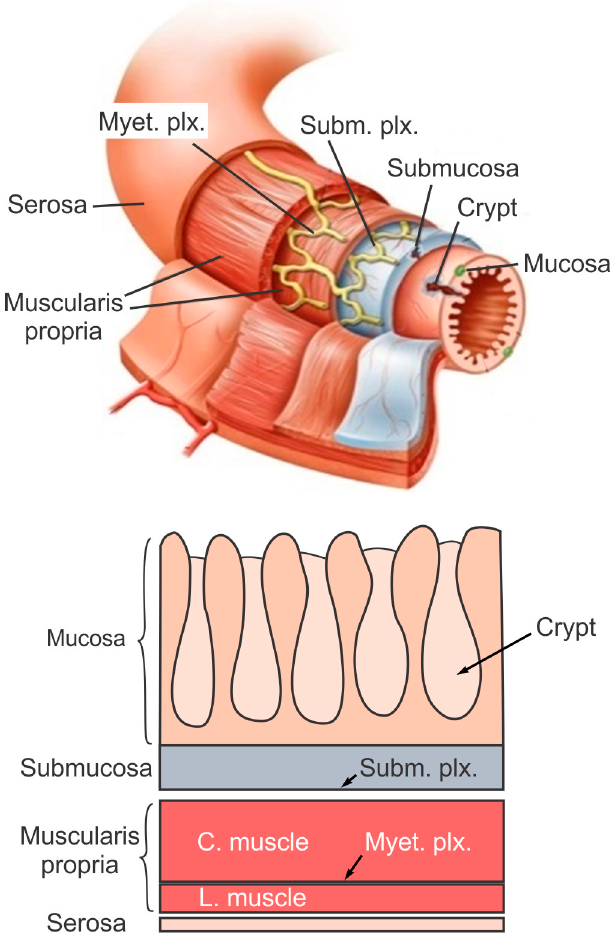
Figure 1. The layered structure of the large intestine. Subm. plx. = submucosal plexus; Myet. plx. = myenteric plexus; C. muscle = circular muscle layer; L. muscle = longitudinal muscle layer. Adapted from [44] with permission.